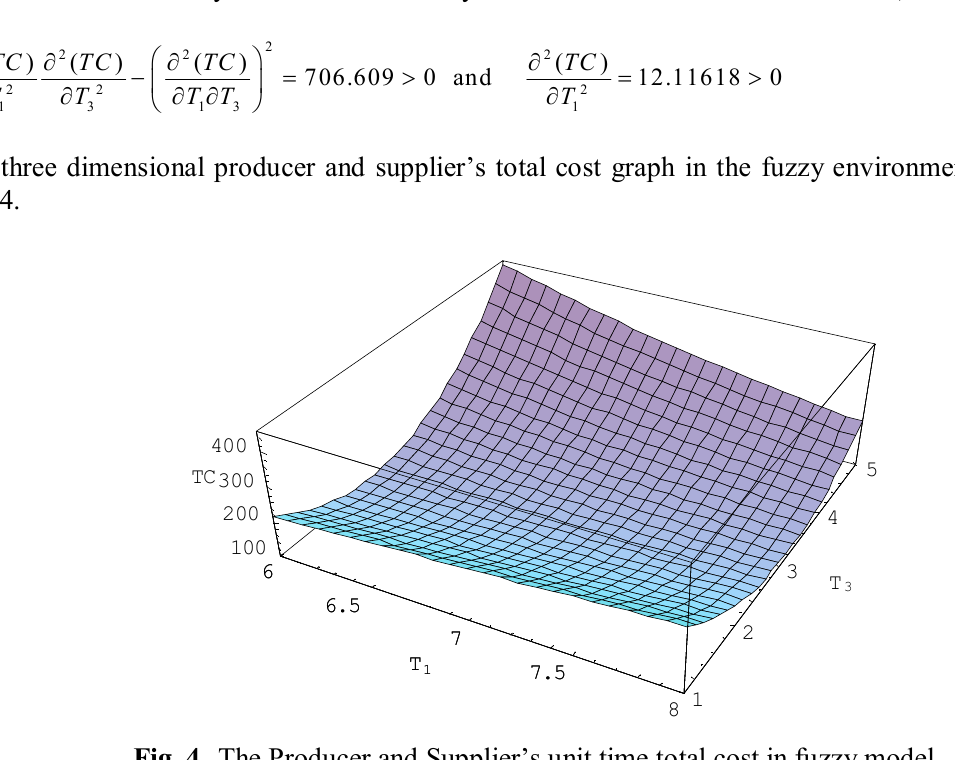
Fig. 4. The Producer and Supplier’s unit time total cost in fuzzy